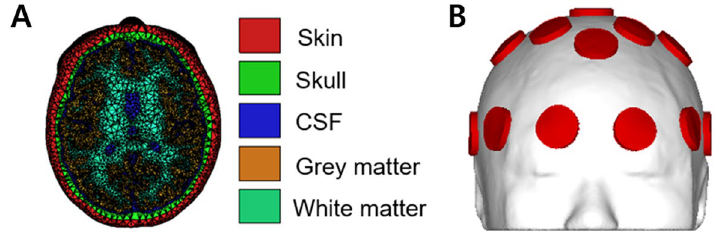
Figure 2. The model used for FEM calculation. ( A ) MRI-based realistic finite element model; consists of the skin, skull, cerebrospinal fluid, gray matter, and white matter, ( B ) scalp surface with circular electrodes with an area of 8 cm 2 generated.